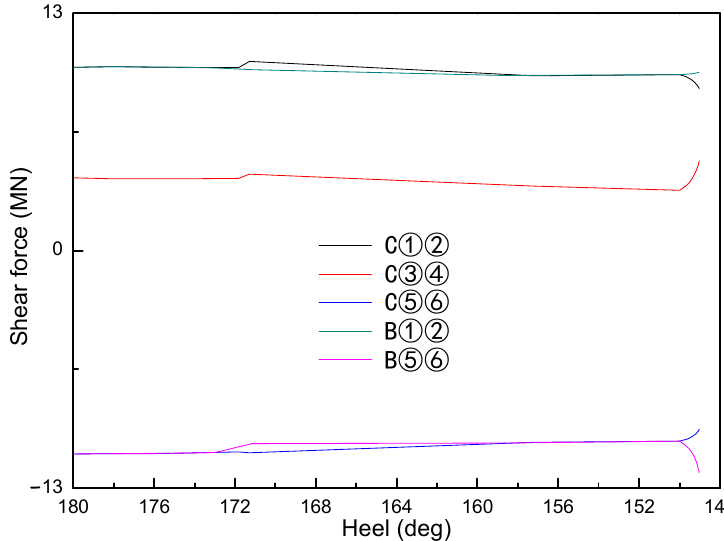
Figure 5. Variation of shear force under case Ⅲ .